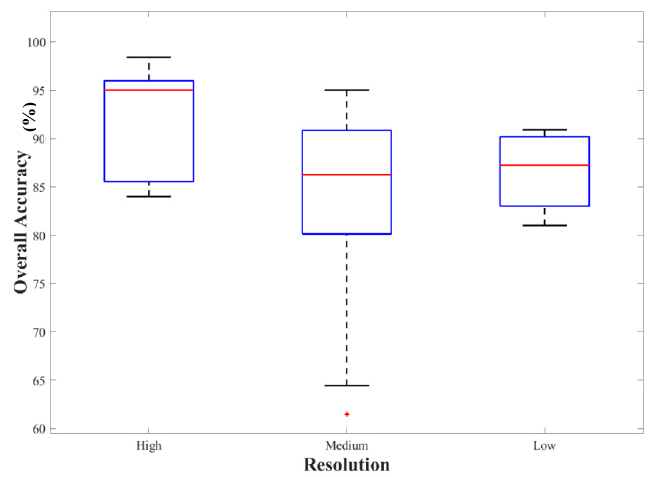
Figure 16. Comparison of used resolution impact on overall accuracies. High resolution refers to resolution lower than 4 m. Medium resolution corresponds to resolution between 4 and 30 m, and low resolution is more than 30 m.